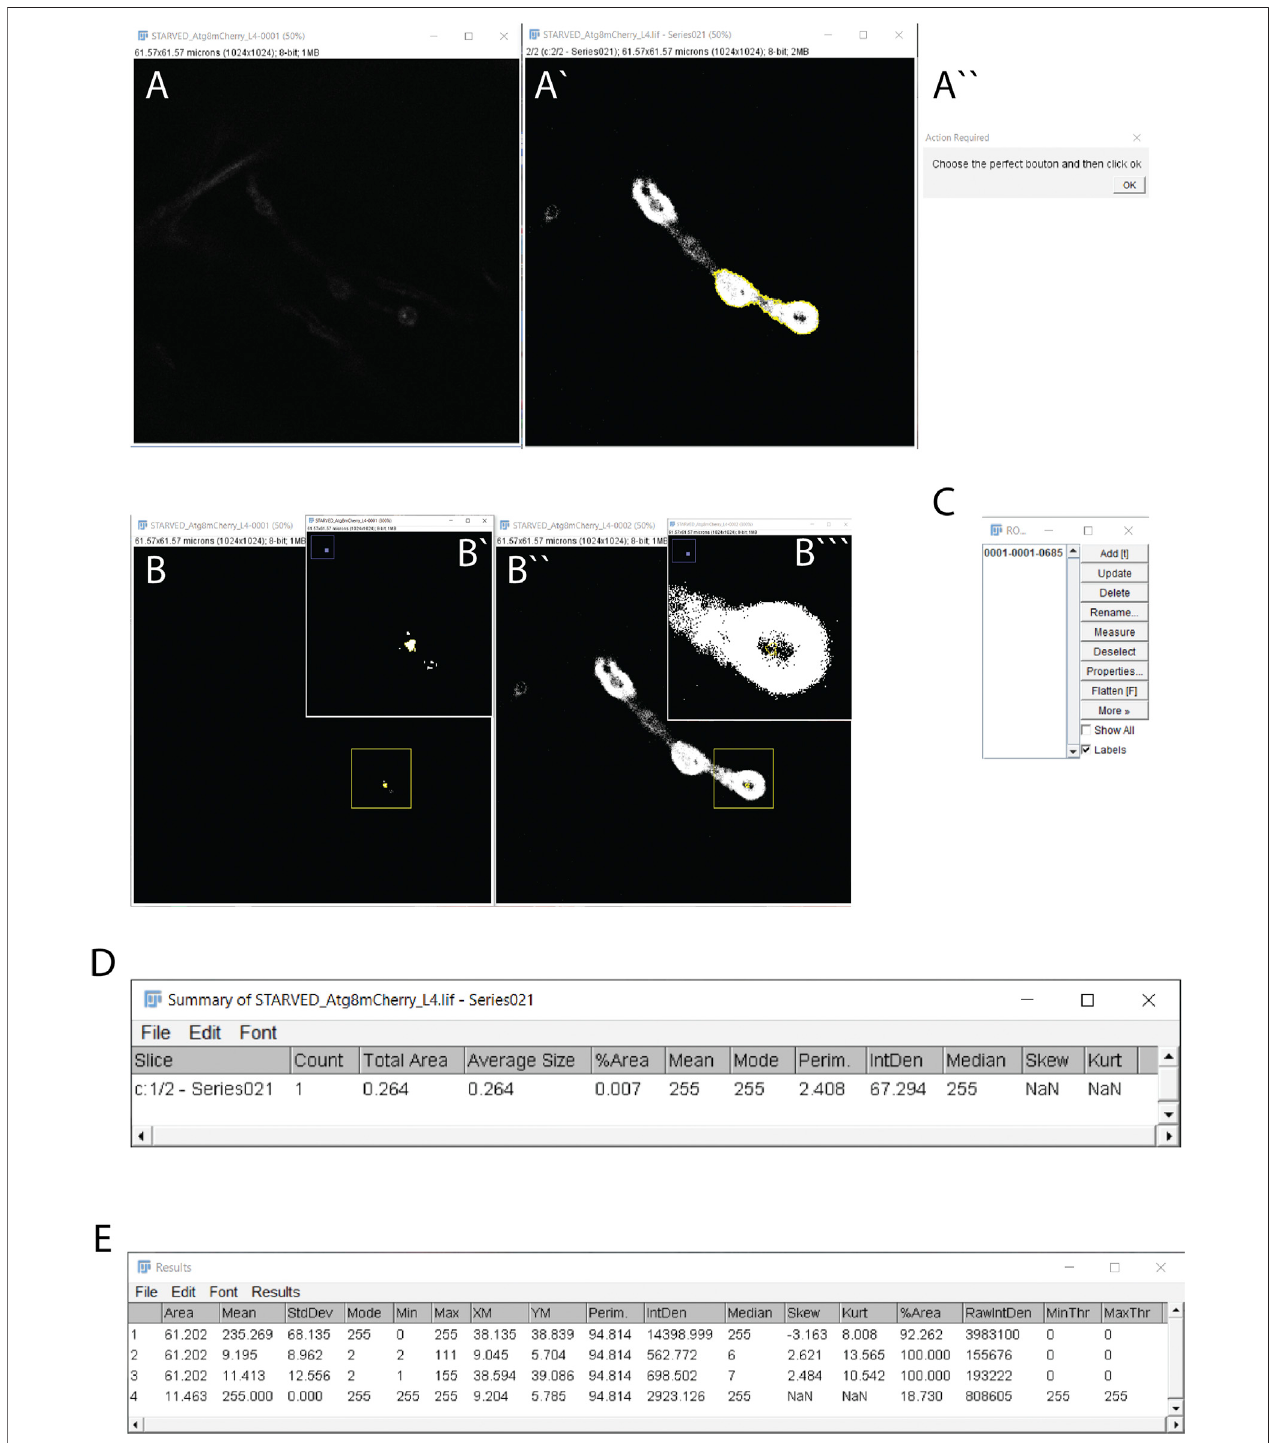
FIGURE3| Autophagoquantmacroworkingstepsandresults. (A – A ” ) Thewindowsareobtainedautomaticallywhenyoustartrunningthemacro. (A) Theoriginal Atg8-mCherry confocal image (protein-channel) in 8-bit and (A`) the DLG channel is marking the postsynaptic compartment (DLG) after thresholding by the Otsu algorithm.TheyellowoutlineappearswhenyouselecttheROIbyusingthewandtoolinthiswindow. (A``) Thewindowtocon fi rm(clickingOK)toselecttheshapeofyour neuron. (B,B ’’ ) Afterthe “ chooseyourperfectbouton ” action,thesewindowsappear. (B,B ’ ) TheAtg8-mCherrychannel(protein-channel) isthresholdedinsidethe DLG selection. Note, in whiteappears only the pixelswith a value higher than the mean plus 4 times the standard deviation. Ifthe size ofthe pixel connected is inside the range you set (0.09 – 0.5 μ m) it will appear with a yellow outline. (B ’’ ,B ’’’ ) The DLG channel is thresholded and its magni fi cation with the dot to see them clearly inside the DLG channel. (C) Window with the ROI manager in which all the dots selection (autophagosomes) will be stored (D) The summary window in which all the dots will be counted and characteristics of all of them together will be taken into account (E) The result window.